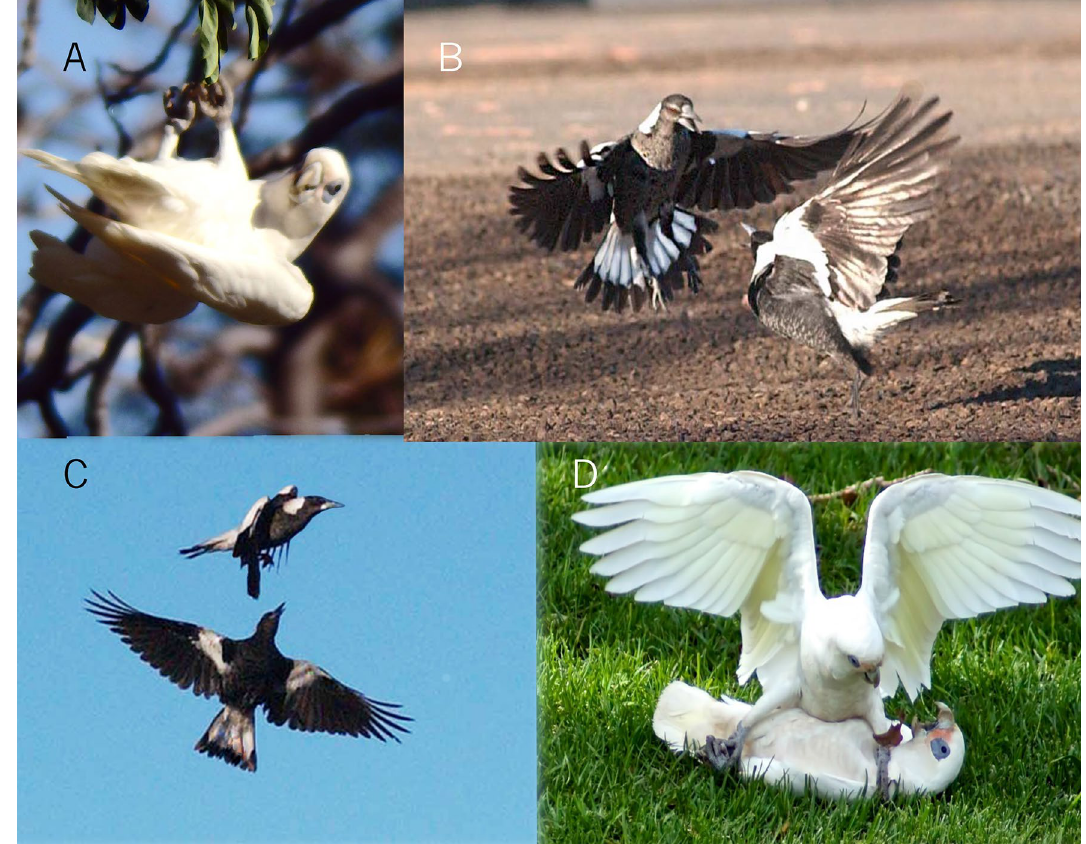
Figure 7. Four different play contexts. ( A) Solo play by little corella ( Cacatua sanguinea )-holding on to small hanging branch with both feet, the bird swings from side to side as fast and as far as it can, as if on a swing. ( B) Social play-wild Australian magpies Gymnorhina tibicen ; juveniles at play (identifiable as juveniles by scalloped grey belly feathers) in mutual intimation and ramming attempts conducted close to the ground-can turn into vigorous play-fighting. ( C) Aerial play fighting/chasing by juvenile magpies: the aim of the pursuer is to get hold of a tail feather and destabilise the bird in front. ( D) Object play of one little corella turning into play-fighting: Note the small dark spot on the left leg of the dominant bird (a desiccated leaf). The other bird had ‘owned’ that leaf but the dominant one tried to snatch it and, in that attempt, subdued the original holder of the leaf. Note that the bird lying on its back has clasped the right foot of the bird above, giving it a hold on the dominant bird. They can wrestle by locking on to the opponent’s foot and then roll around for a wrestling match. Often, the original prize is entirely forgotten and a few seconds or minutes later they feed peacefully next to each other. (Credits: A, B, and C by author; D: Bobbi